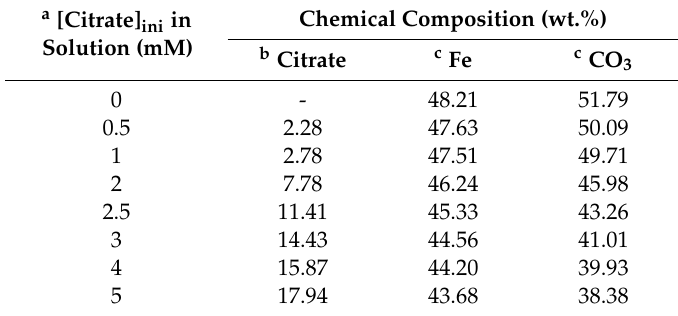
Table 1. Chemical composition of the CF-NC samples synthesized in the presence of di ff erent citric acid concentrations (0–5